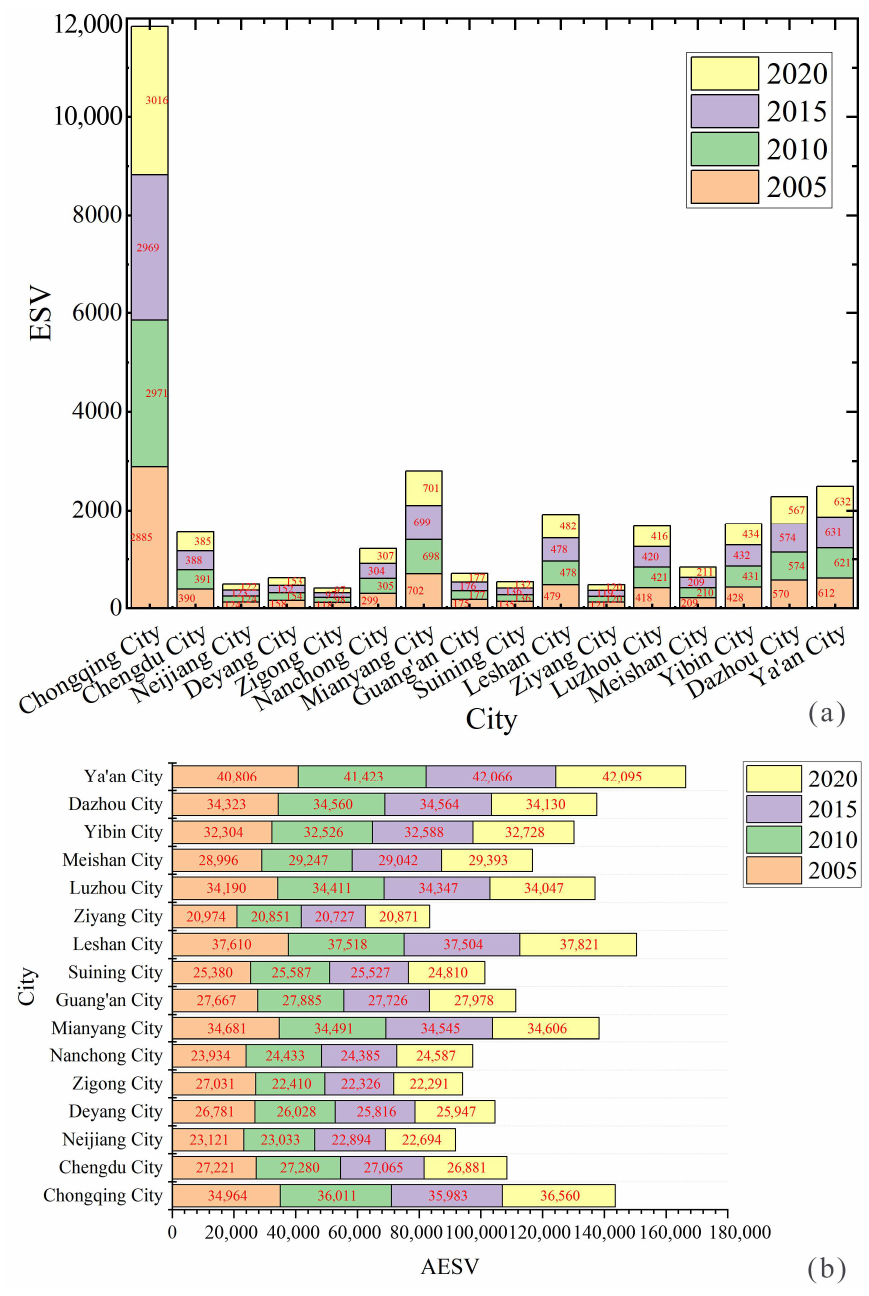
Figure 6. Changes in land ecosystem service values and land-average land ecosystem service values, 2005–2020.( a ) is a graph comparing the ESV of cities. ( b ) is a graph comparing the AESV of cities.